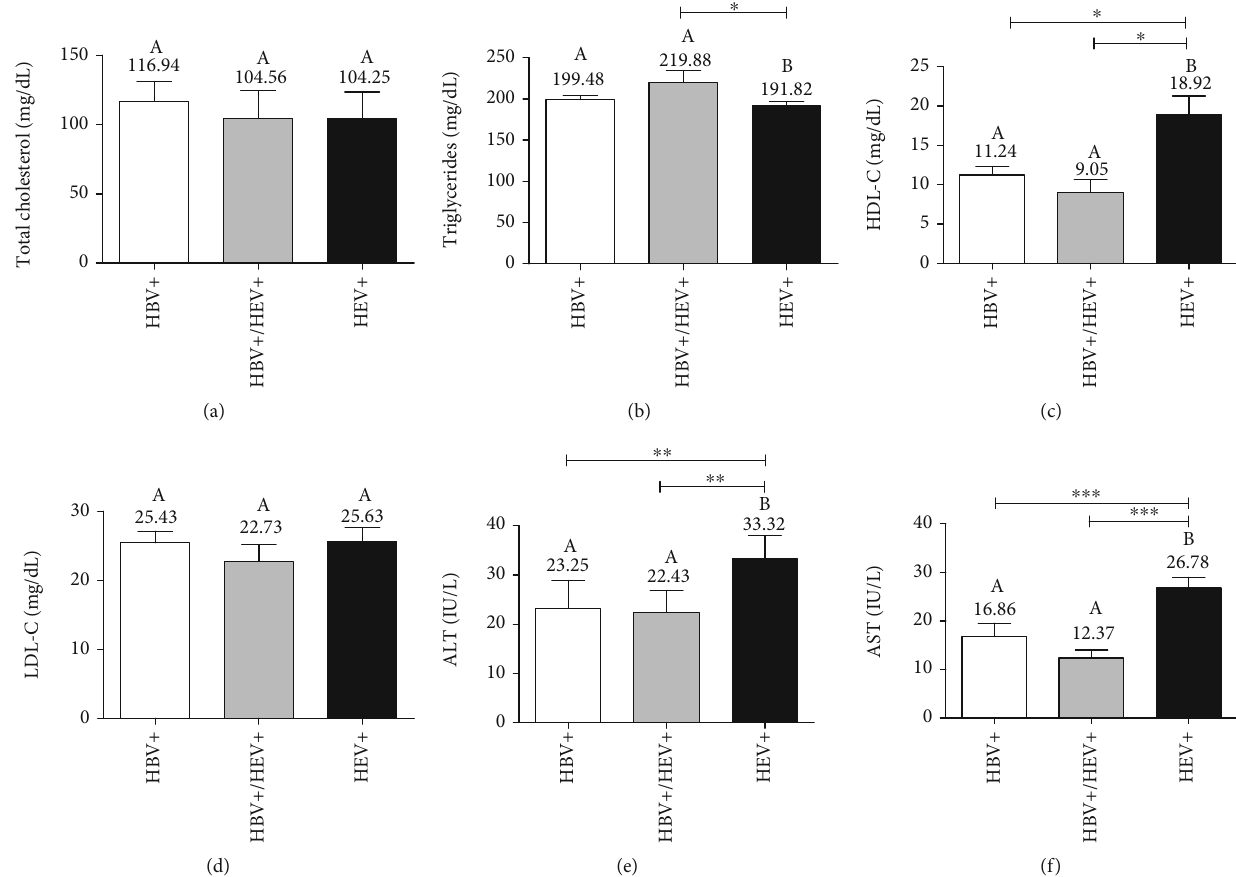
Figure 2: Mean cholesterol, triglycerides, and transaminase levels between HBV/HEV-coinfected and monoinfected subjects. (a) Total cholesterol levels. (b) Triglycerides levels. (c) HDL-cholesterol (HDL-C). (d) LDL-cholesterol (LDL-C). (e) Alanine aminotransferase (ALT) levels. (f) Aspartate aminotransferase (AST) levels. Comparison was carried out using the nonparametric Kruskal-Wallis test followed by Dunn ’ s multiple comparison post hoc test. ∗ p < 0 : 05 , ∗∗ p < 0 : 01 , and ∗∗∗ p < 0 : 001 . Bars with di ff erent letters are signi fi